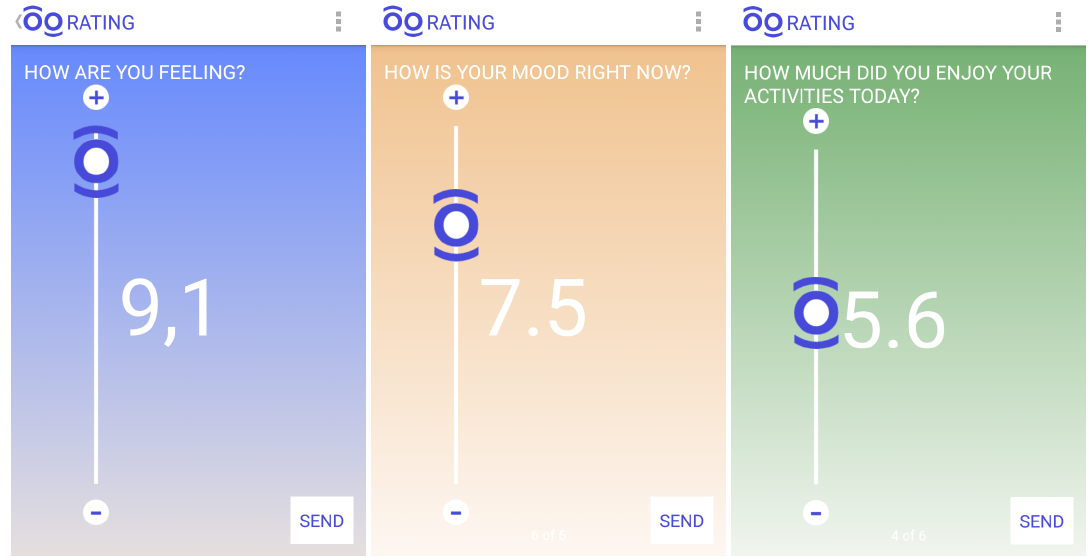
Figure 1. MoodBuster mobile GUI for requesting patient